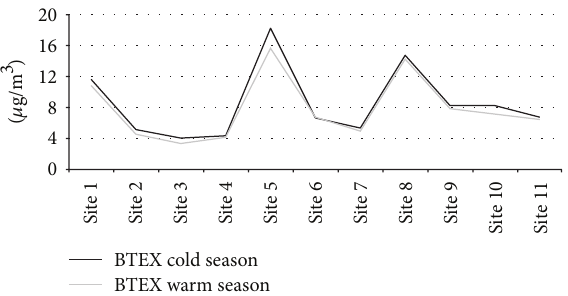
Figure 4: BTEX concentrations during the warm season (April– September) and cold season (October to March).